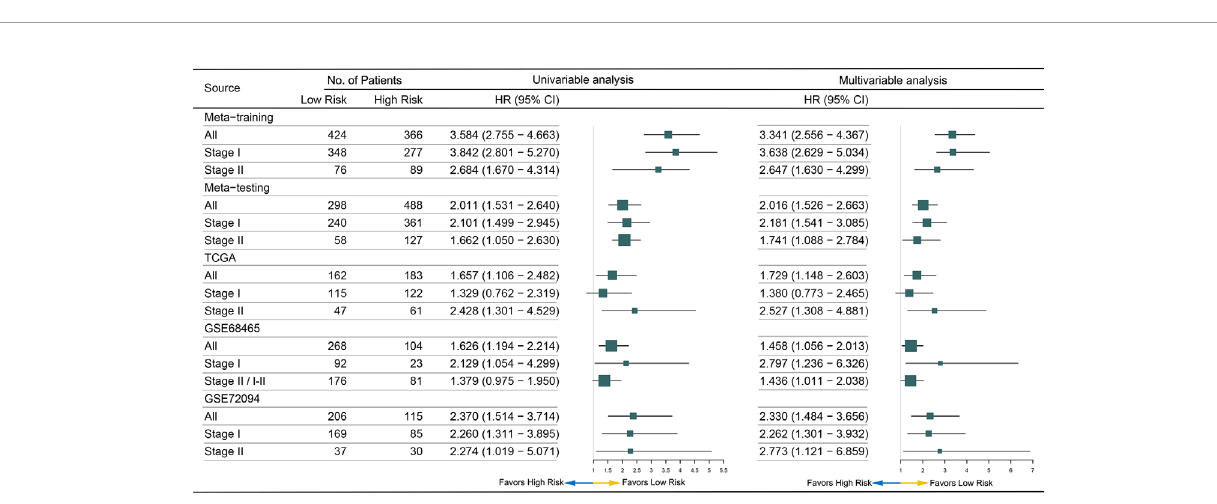
FIGURE 3 | Forest plot for the hazard ratios (HRs) of high vs low metabolism-related gene pair index (MRGPI) risk